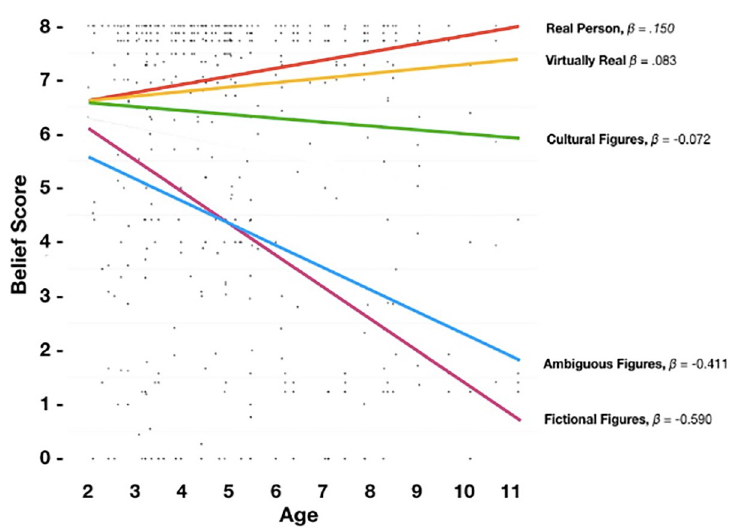
Fig 4. Results of the multilevel model in which a child’s age interacts with category of figure.